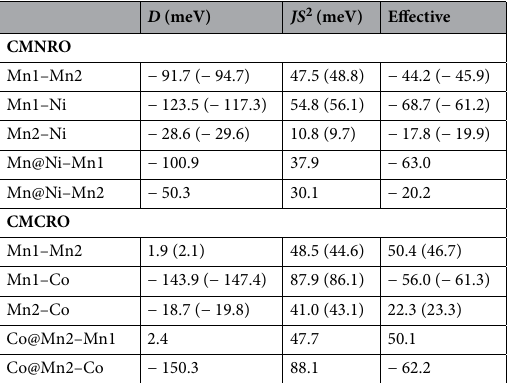
Table 1. Estimates of the coupling constants connecting the core spins for the double-exchange and super- exchange mechanisms operative in CMNRO and CMCRO, as estimated employing the super-exchange formula and total energy calculations of different spin configurations. Negative (positive) signs indicate ferro- (antiferro-) magnetic interactions.